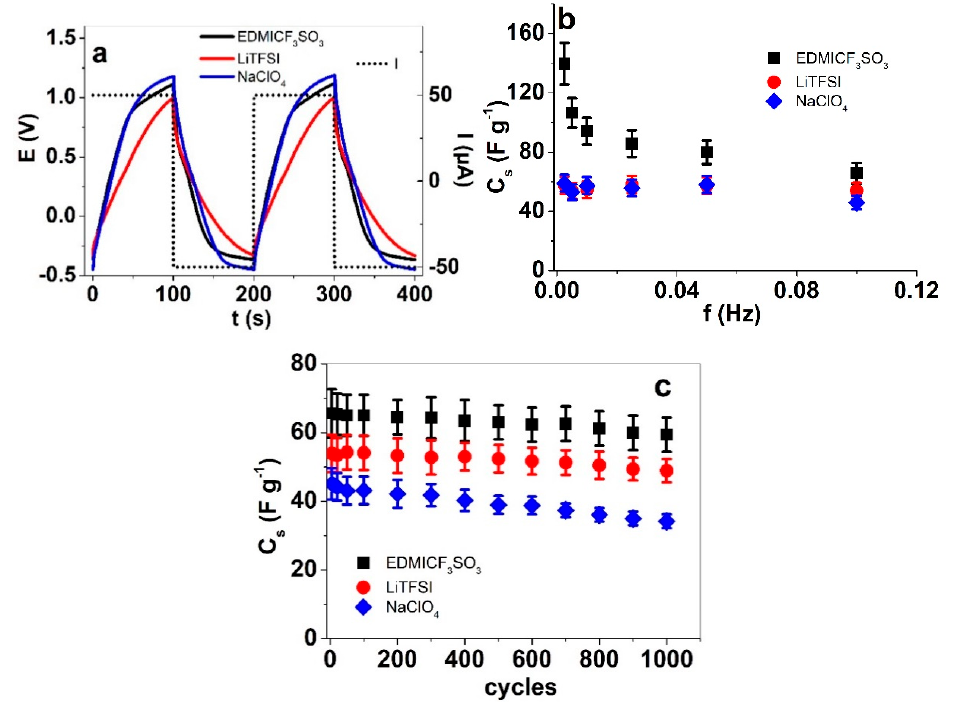
Figure 7. Square wave current steps of PP–IPN trilayers showing in ( a ) the potential time evolution (3rd to 4th cycle) at 0.005 Hz and current ± 50 µA (dotted) and ( b ) the specific capacitance vs. frequency; and ( c ) the specific capacitance vs. cycle number in long term test at 0.1 Hz (± 1 mA). (EDMICF 3 SO 3 (black, ■ ), LiTFSI (red, ● ) and NaClO 4 (blue, ♦ )).